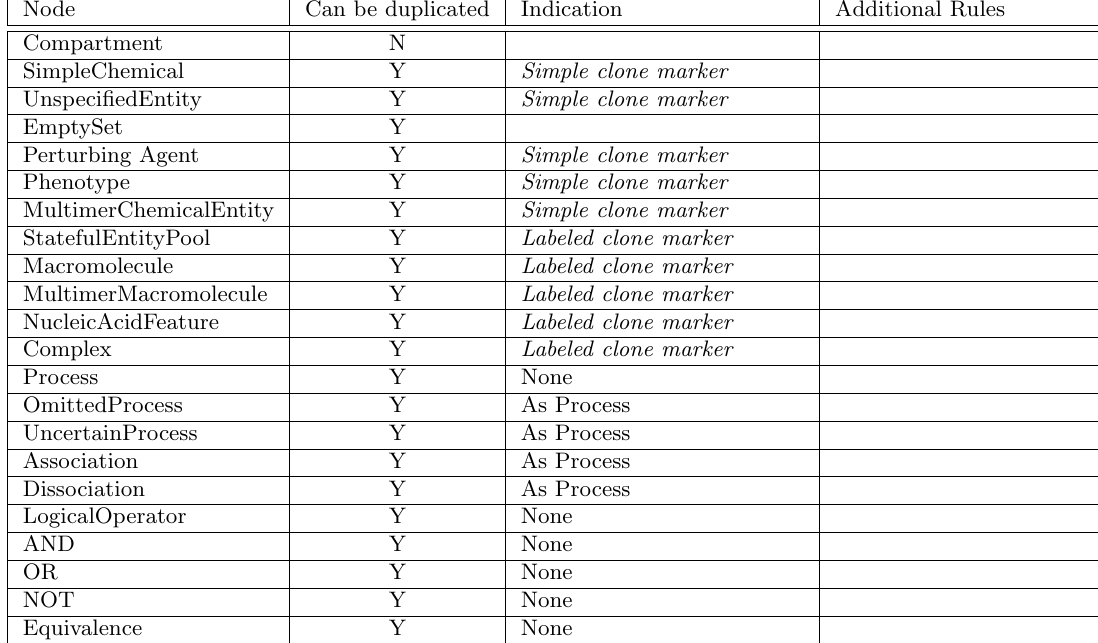
Table 3.2: Duplication